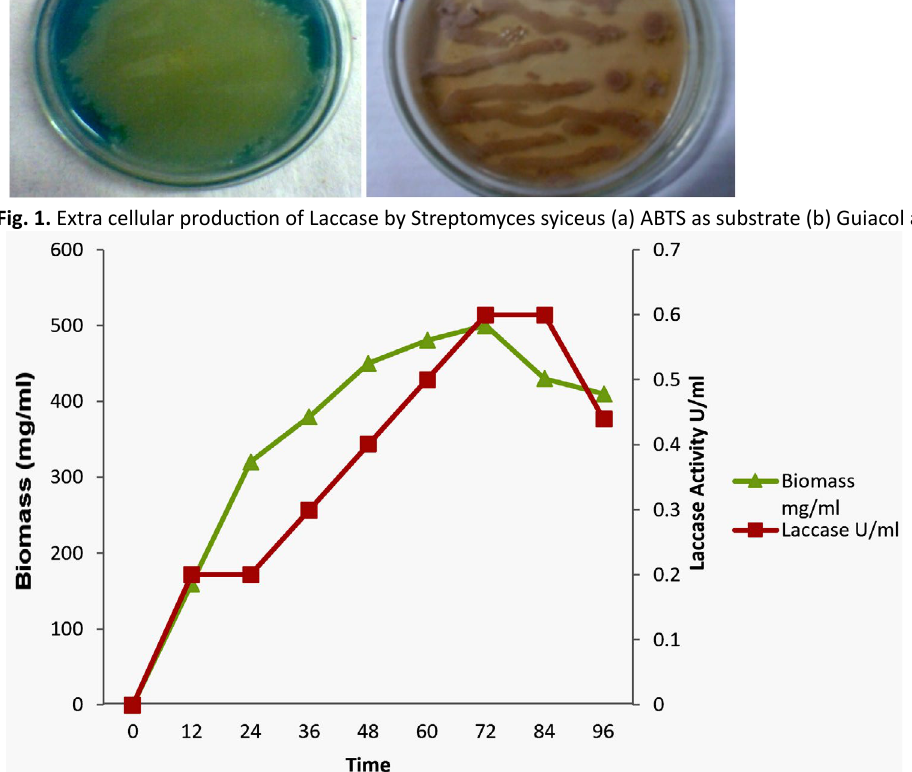
Fig. 2. Effect of time on production of laccase by Streptomyces syiceus strain KN3 purification and characterization of Laccase enzyme